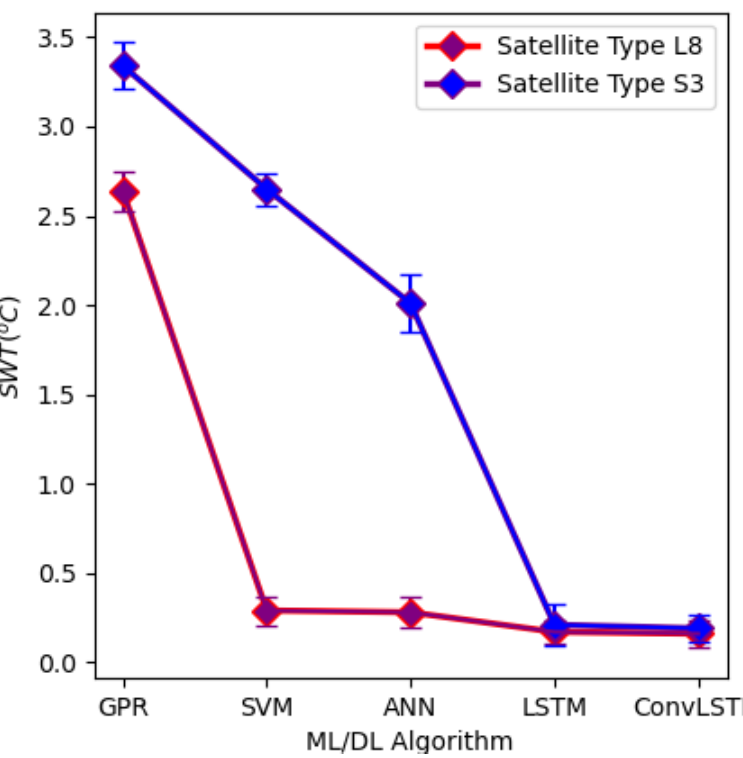
Figure 10. Line plots showing the outcome of a two factor experiment main and interactive effects of satellite type and type of ML/DL.